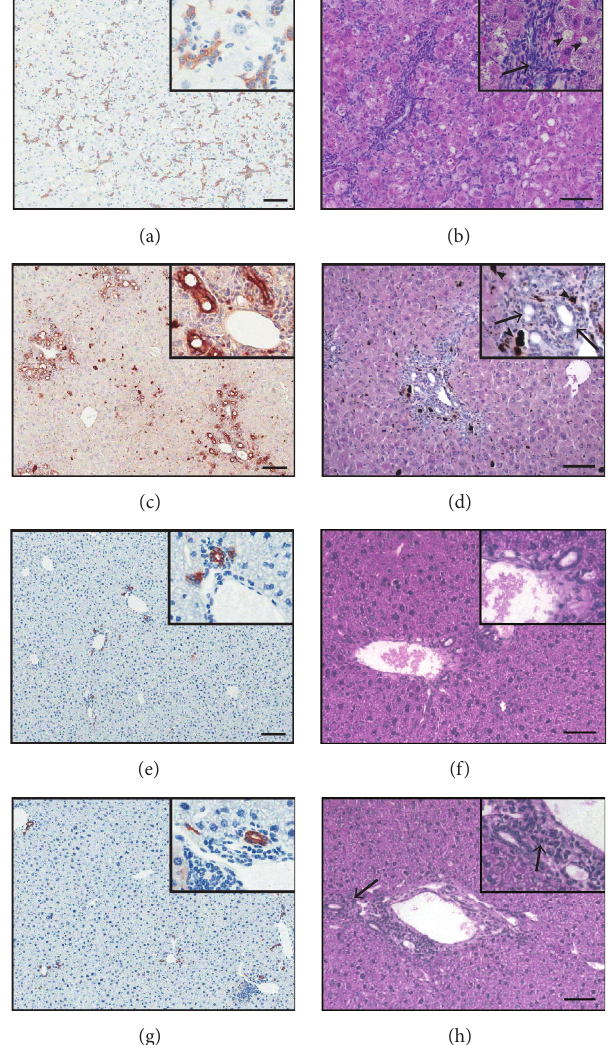
Figure 5: Four liver injury models display different degrees of pathology and liver progenitor cell (LPC) response. Liver sections from wild- type mice subjected to a choline-deficient, ethionine-supplemented (CDE; (a) and (b)) or 3,5-diethoxy-carbonyl-1,4-dihydrocollidine (DDC; (c) and (d)) diet, or transgenic 178.3 ((e) and (f)) or Met-Kb ((g) and (h)) mice were stained with panCK ((a), (c), (e), and (g)) or H&E ((b), (d), (f), and (h)). Arrows in panels (b) and (d) and (h) indicate LPCs, ductular reactions, and small basophilic cells, respectively. Arrowheads in panels (b) and (d) indicate steatosis and porphyrin accumulations, respectively. Scale bars represent 100 𝜇